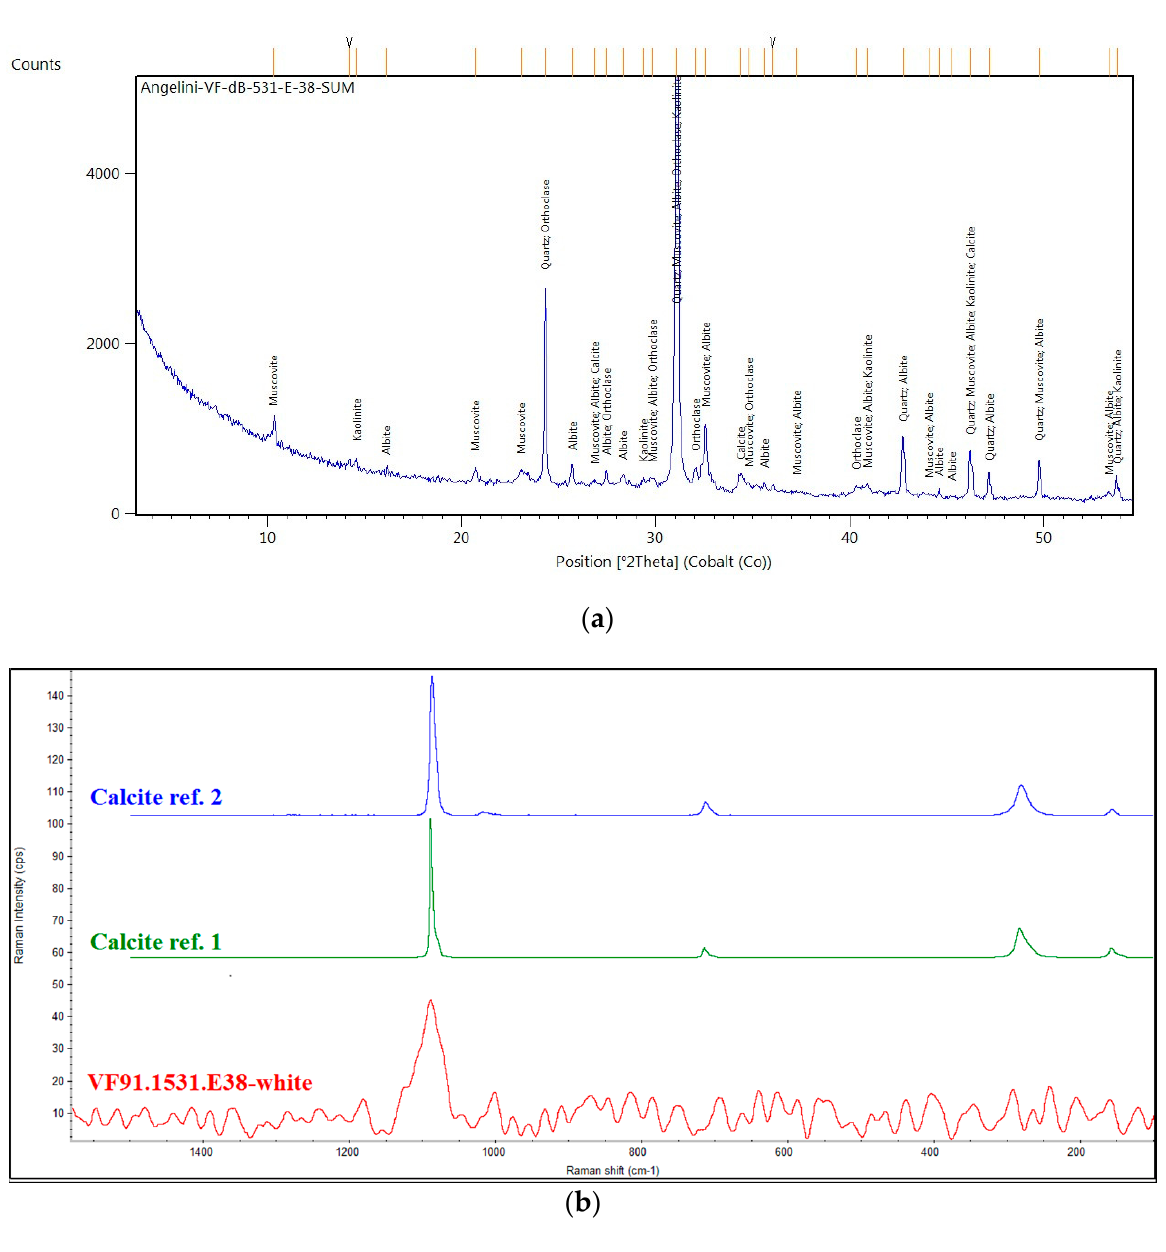
Figure 5. ( a ) XRPD diffractogram measured on the white coating of dice VF91.1531.E38; ( b ) Raman spectroscopic signal of the white coating of the same dice (red), compared with the spectra of reference calcite (green and blue).